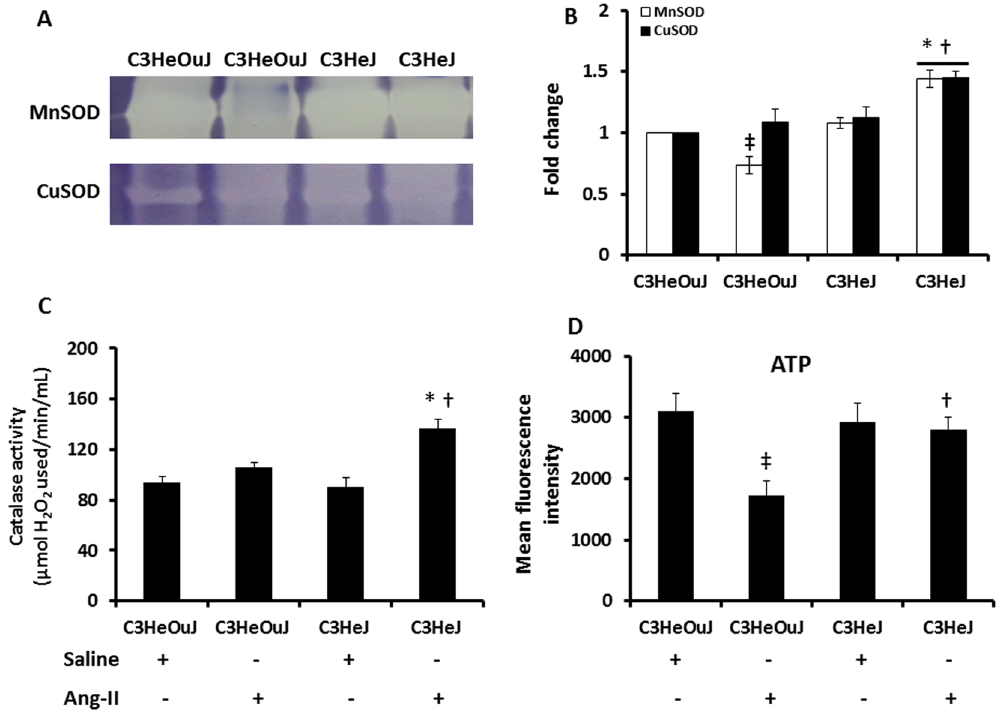
Figure 7. The enzyme activity of MnSOD, CuSOD, catalase and the levels of ATP are decreased following Ang-II treatment in mice with normal TLR4. ( A ) Representative images of gels stained for MnSOD and CuSOD activity. Hundred micrograms of protein were separated in 12% native gels as described in the Materials and Methods. ( B ) Data shows fold change of mean intensity ± SEM, n = 6/group. ( C ) The residual amount of H 2 O 2 was used as a surrogate for catalase activity. Data shows catalase activity ( µ mol of H 2 O 2 used/min/mL) as mean ± SEM. ( D ) Data showing ATP levels in all groups as mean fluorescent intensity ± SEM. n = 5/group, tested by Kruskal-Wallis test and Mann-Whitney rank sum test. * p < 0.05 vs. C3HeJ + saline, † p < 0.05